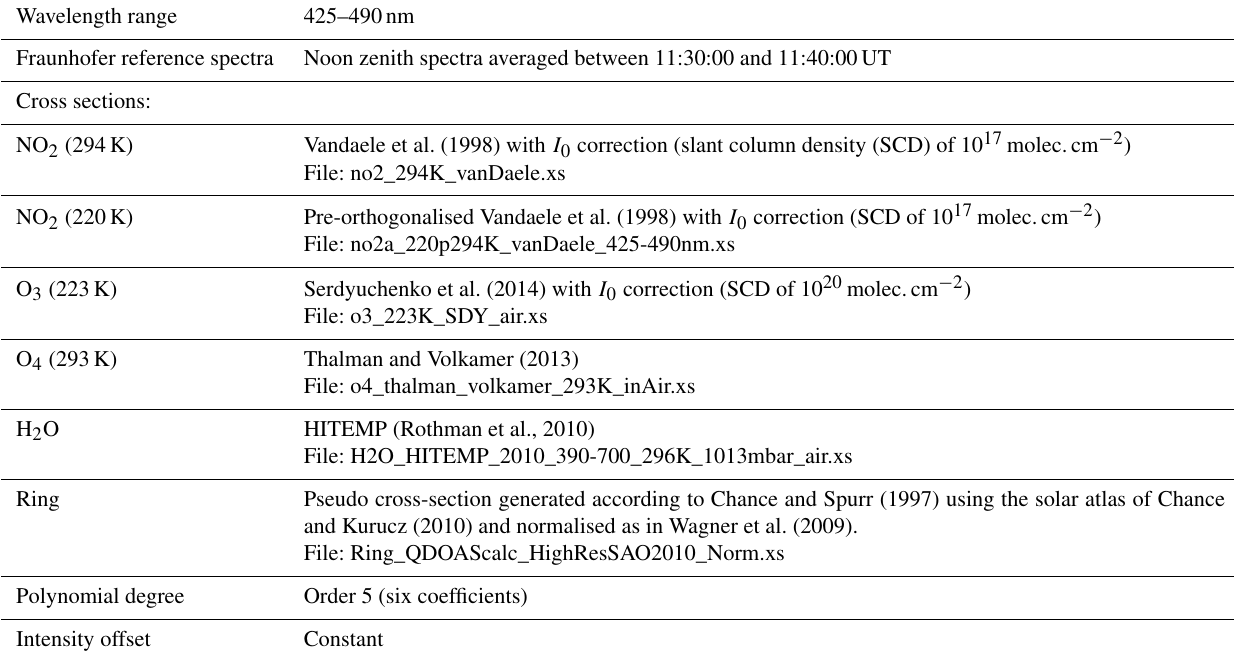
Table A1. DOAS settings for NO 2 and O 4 (visible